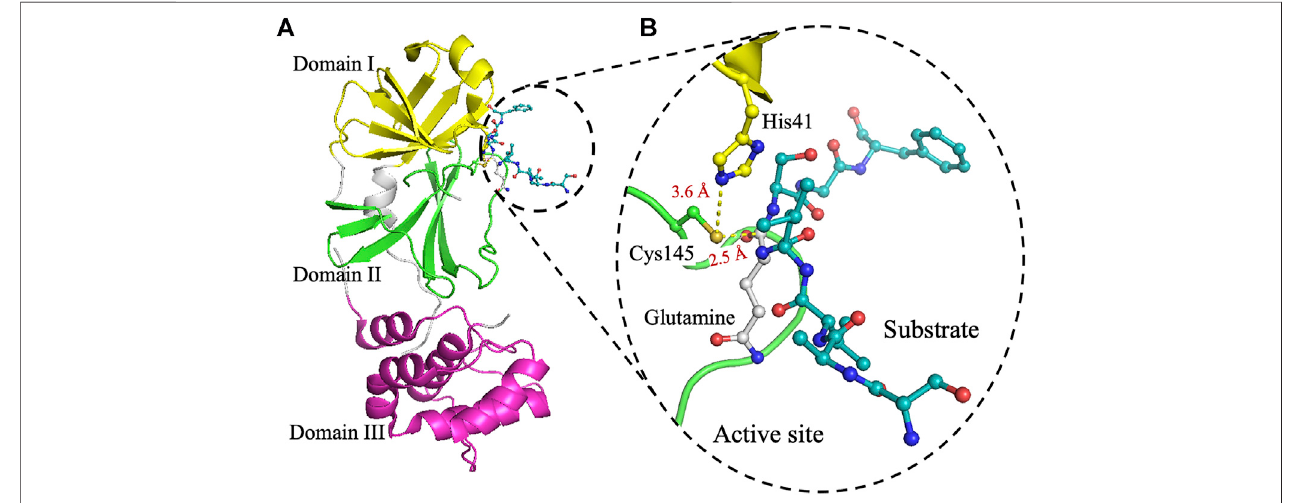
FIGURE 1 | The crystal structure of 3CLpro. (A) Cartoon representation of 3CLpro of SARS-CoV-2 (PDB code 6Y2E) with domain I (residues 10 – 96) is shown in yellow, domain II (residues 102 – 180) in green, and domain III (residues 200 – 303) in pink. The peptide-substrate (blue) is shown in ball and stick representation, and it is located at the interface between domains I and II. (B) The active site of 3CLpro showing the peptide-substrate in blue and glutamine at P1-site is white. The catalytic residueCys145,whichispartofdomainII,is2.5 Åfromthebackbonecarbonylcarbonofglutamineofthepeptide-substrate.Residuesofthecatalyticdyad,His41 in domain I, is 3.6 Å from Cys145 in domain II. The fi gure was prepared using PyMol (Schrodinger LLC).